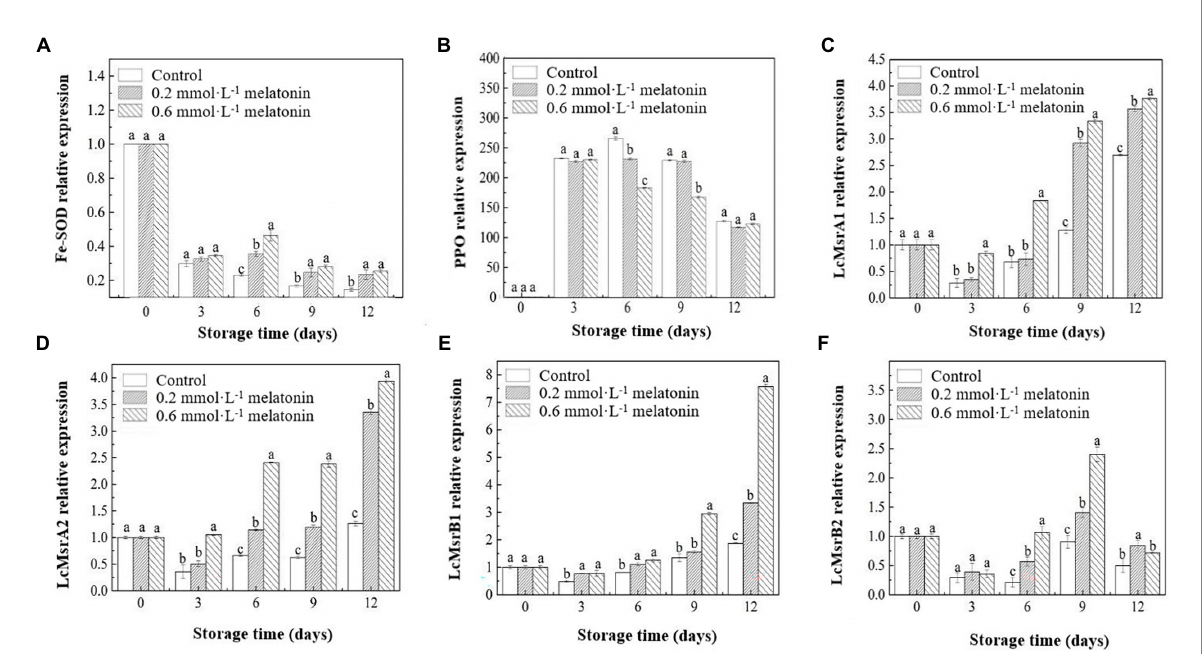
FIGURE 6 Relative expression levels of (A) Fe-SOD, (B) PPO, (C) LcMsrA1, (D) LcMsrA2, (E) LcMsrB1, and (F) LcMsrB2 of the peel samples during cold storage. Data represent mean values and standard errors of three replicates. Different lowercase letters (a − c) indicate significant differences between different groups ( p <